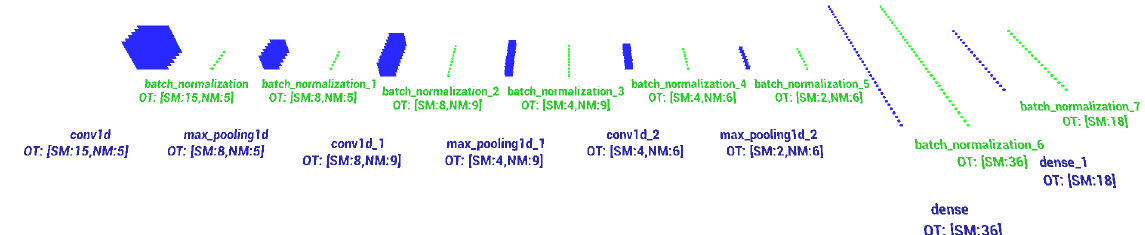
Figure 6. Structure of the CNN used for radar signal recognition, where OT is the output tensor, SM is the size map or number output of the dense layer, and NM is the number of maps.